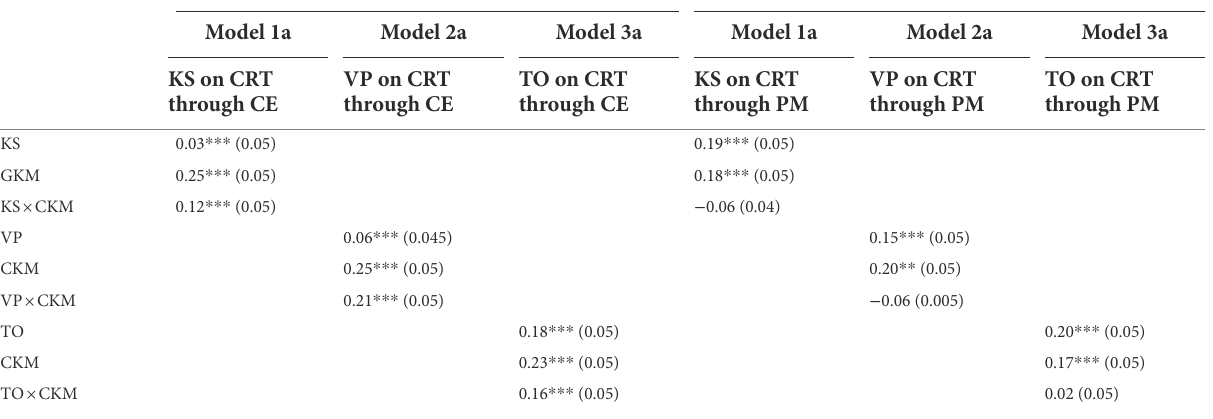
TABLE 6 Results for moderated mediation.